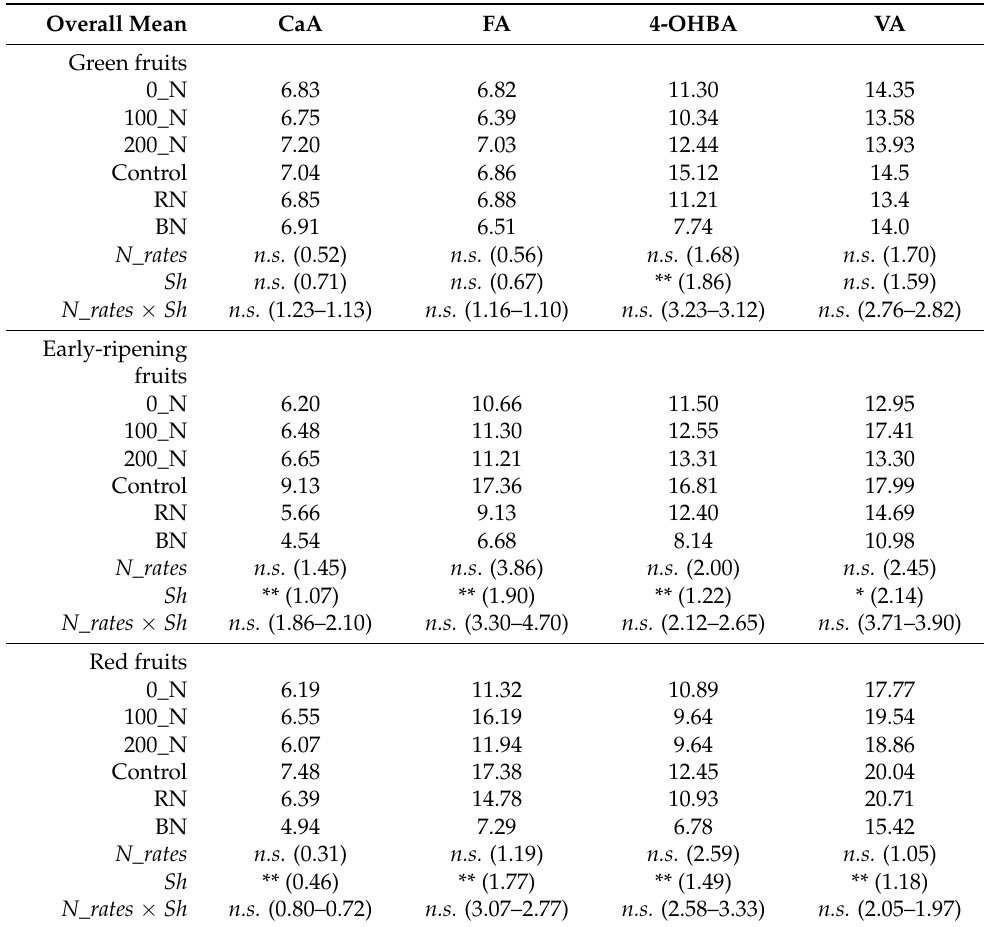
Table 5. Overall means and F-test from the analysis of variance (ANOVA a ) performed on phenolic acid content ( µ g g − 1 dry weight) data: caffeic acid (CaA), trans-ferulic acid (FA), 4-hydroxybenzoic acid (4-OHBA) and vanillic acid (VA). Phenolic acids were analyzed on pepper fruits from plant 200 kg N ha − 1 ) and shade levels (Sh; accomplished using: no cover, Control; red photoselective